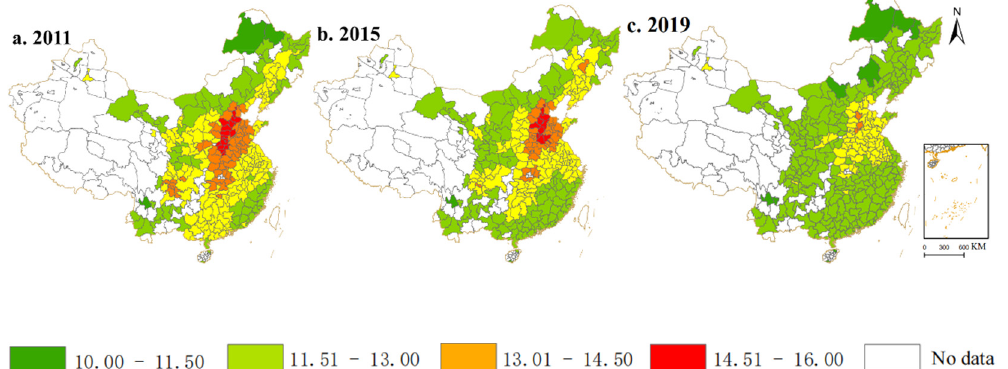
Figure 2. Spatial-temporal evolution pattern of China’s PM 2.5 emissions. Note : Drawn by authors using ArcGIS 10.6. ( a – c ) are the serial number of the pictures.